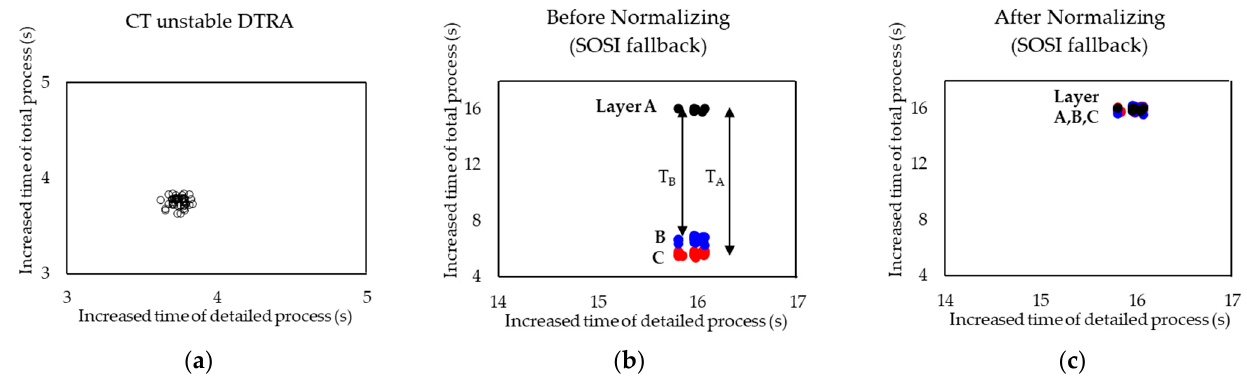
Figure 4. ( a ) Shows clustering without normalization, and ( b , c ) show before and after normalization of SOSI fallback, which is a specific process.